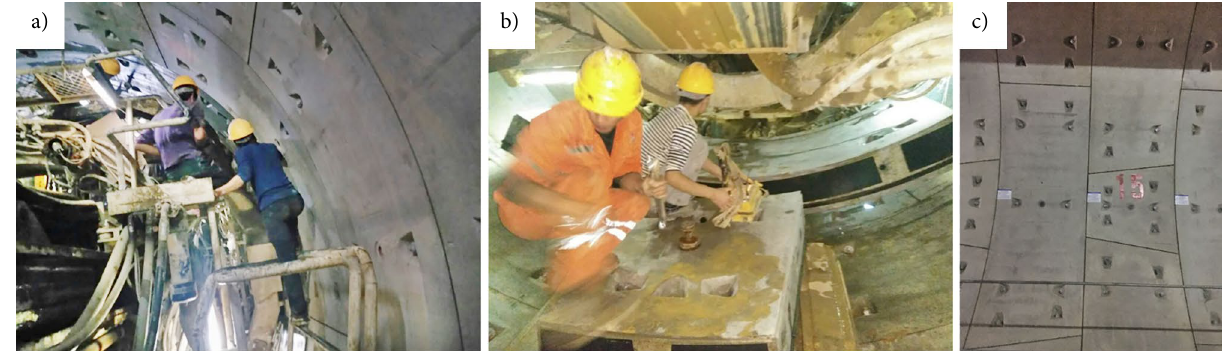
Figure 15. Some observations from the on-site safety patrol: a – Joint sealing; b – Personnel operation specification; c – Segment